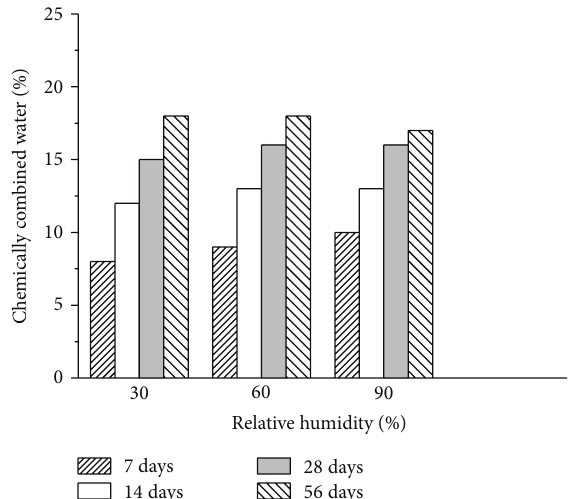
Figure 16: The influence of relative humidity on the CCW of cement paste close to